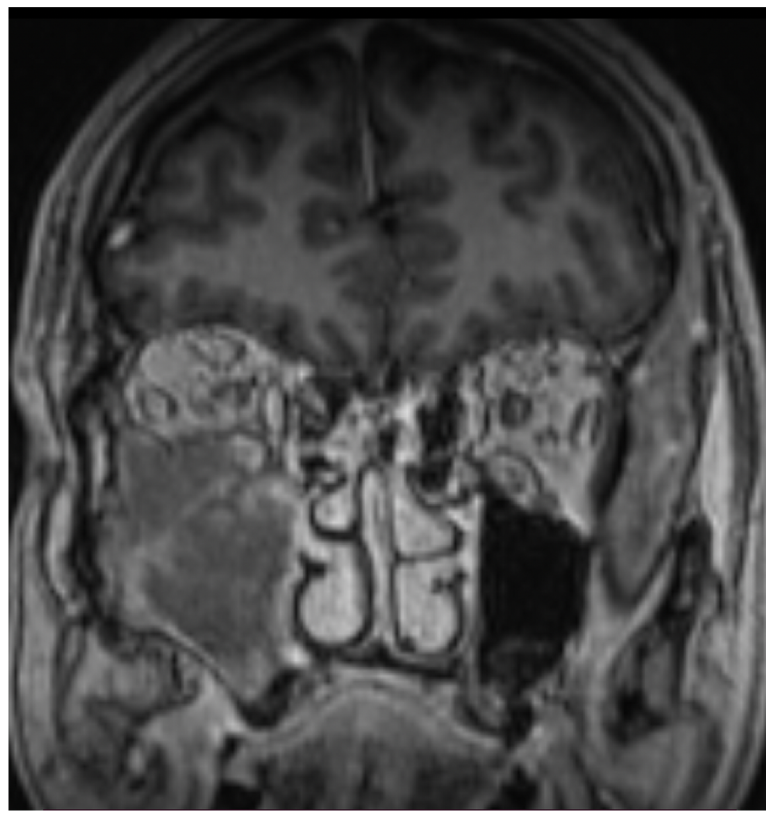
Figure 1. Head MR scan: large tumor evolving from maxillary sinus.